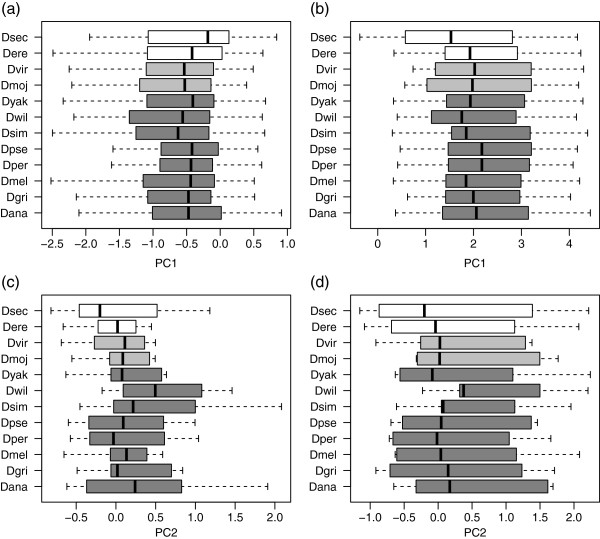
Boxplot showing median ± IQR (box) and 95% CI (whiskers) of standing variation PC score (axes in Figure 1) across 12 Drosophila species, for subset of proteins exhibiting a relationship with diet breadth: (a) PC1, Nucleic acid binding proteins (n = 26); (b) PC1, Transporters (n = 12); (c) PC2, Oxidoreductases (n = 9); (d) PC2, Transferases (n = 9). Species are given in order of diet breadth: white bars, specialist; light grey bars, oligophagous; dark grey bars, generalist. Species names have been abbreviated using their first three letters.